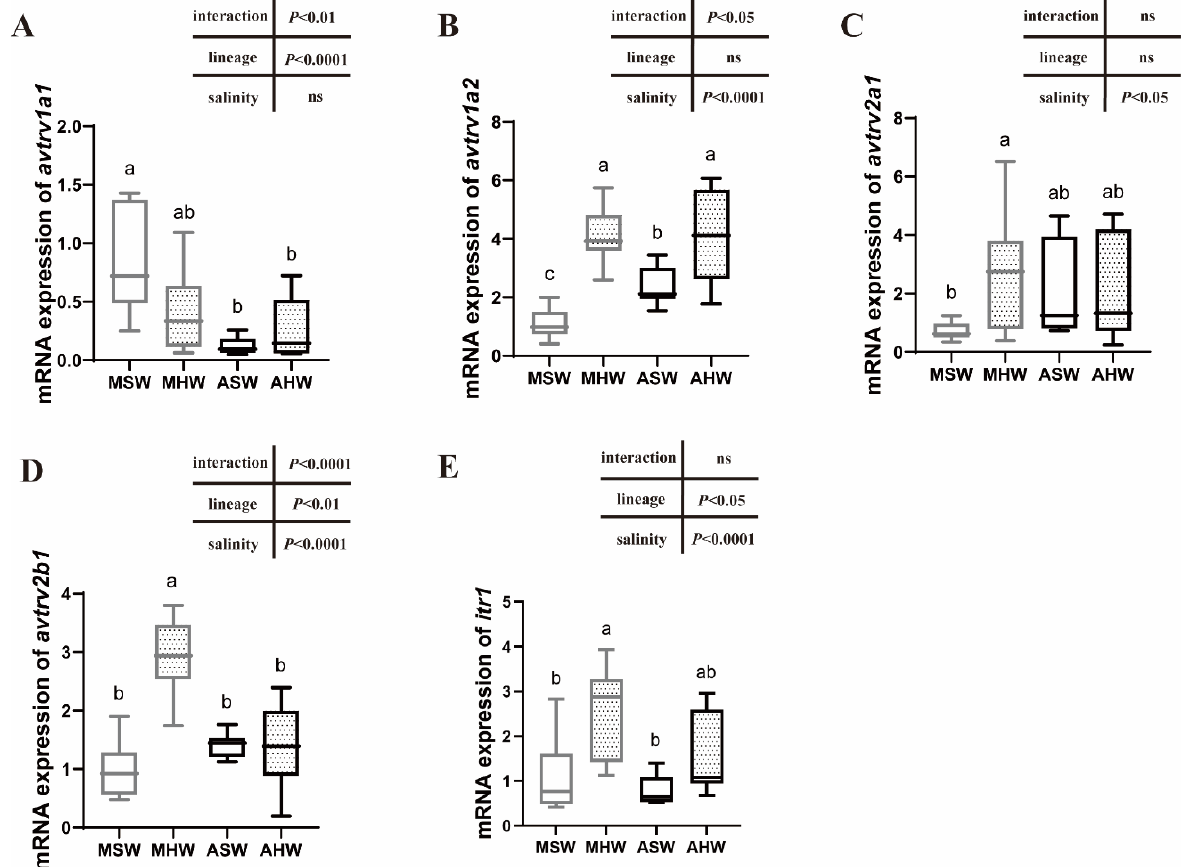
Figure 3. Relative avtrv1a1 ( A ), avtrv1a2 ( B ), avtrv2a1 ( C ), avtrv2b1 ( D ) and itr1 ( E ) mRNA expression were measured in the anterior intestines of Mediterranean (M) and Atlantic (A) European sea bass maintained in seawater (SW) and hypersaline water (HW). Different letters denote significant dif- ferences between groups (two-way ANOVA follow ed by Tukey’s test, p < 0.05, n = 11). Data are between groups (two-way ANOVA followed by Tukey’s test, p < 0.05, n = 11). Data are represented represented as the median, first and third quartiles (box), minimum and maximum values. ns: non significant.